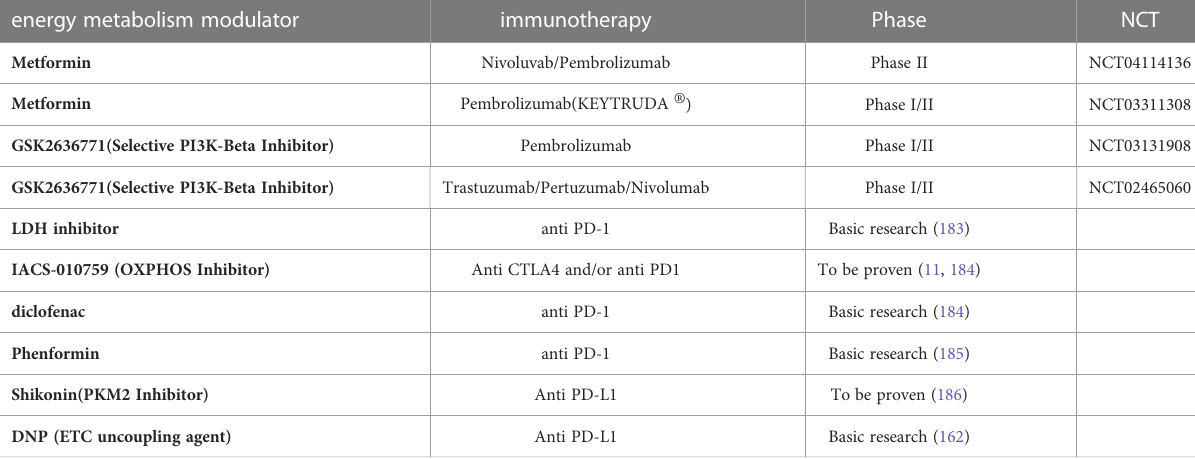
TABLE 2 Combinations of energy metabolism modulators with immunotherapy. energy metabolism